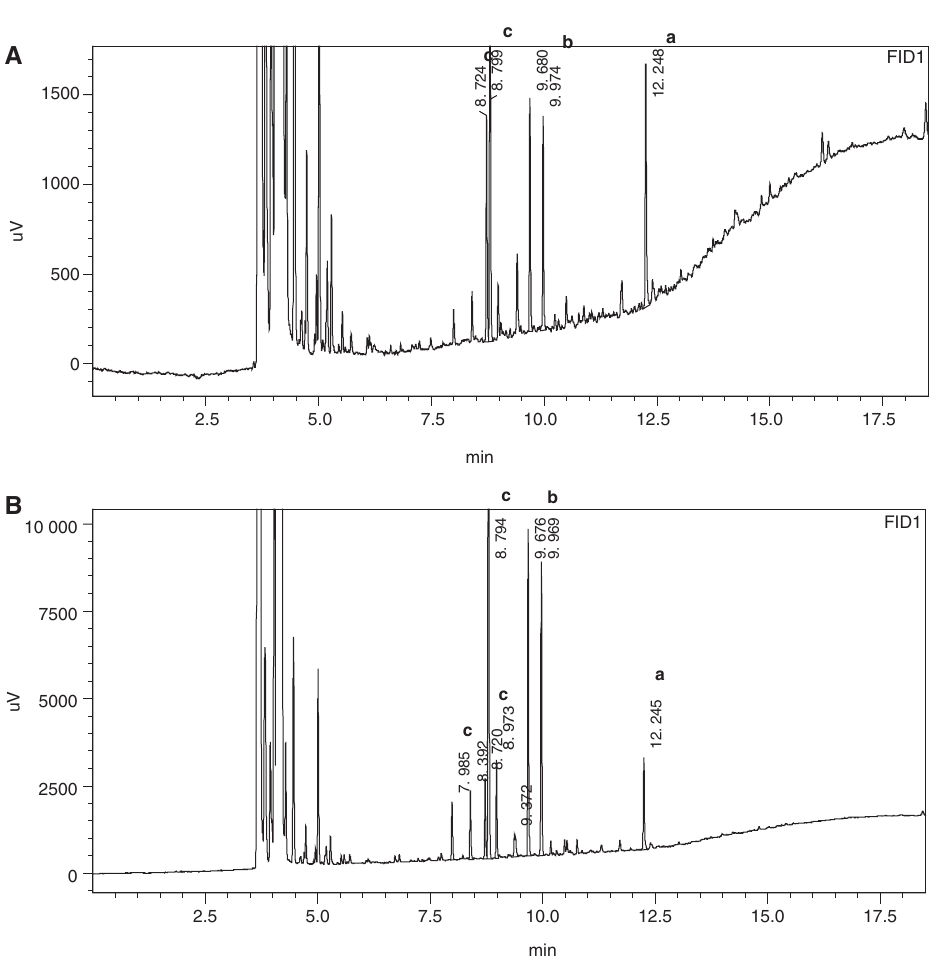
Figure 2: Chromatogram of organic acids produced by A. flavus (F3). (A) Control (without heavy metals) and (B) test with heavy metals. Typical peaks for organic acids by GC/FID at different retention times: a – citric acid, b – malic acid, and c – succinic acid.